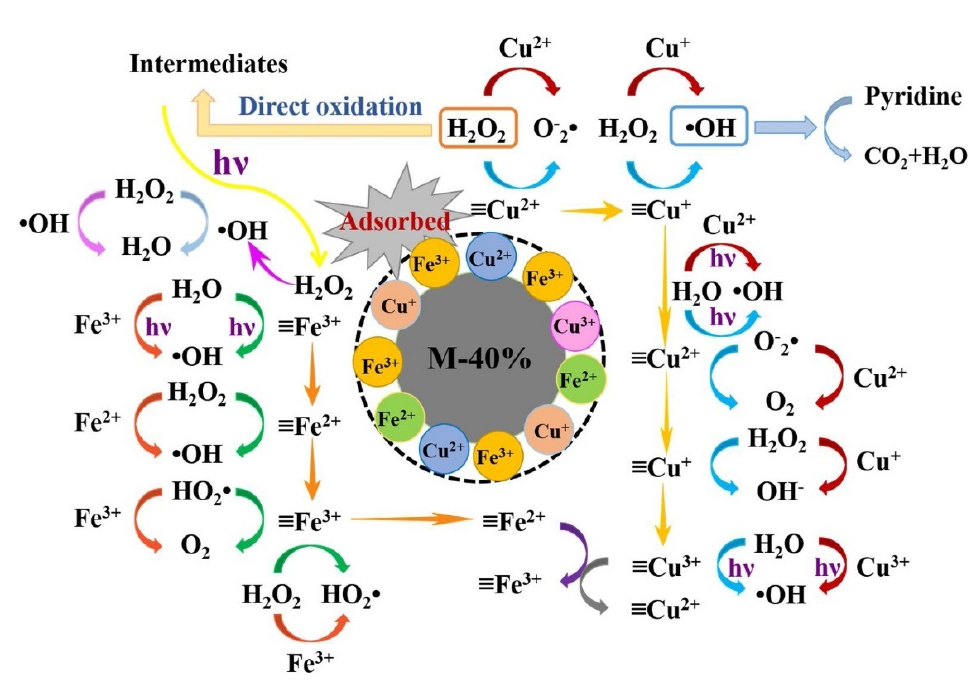
Figure 2. Reaction mechanism proposed for the degradation of pyridine by the UV/M–40%/ H 2 O 2 system. Reprinted with permission from Ref. [39]. Copyright 2020, Elsevier.